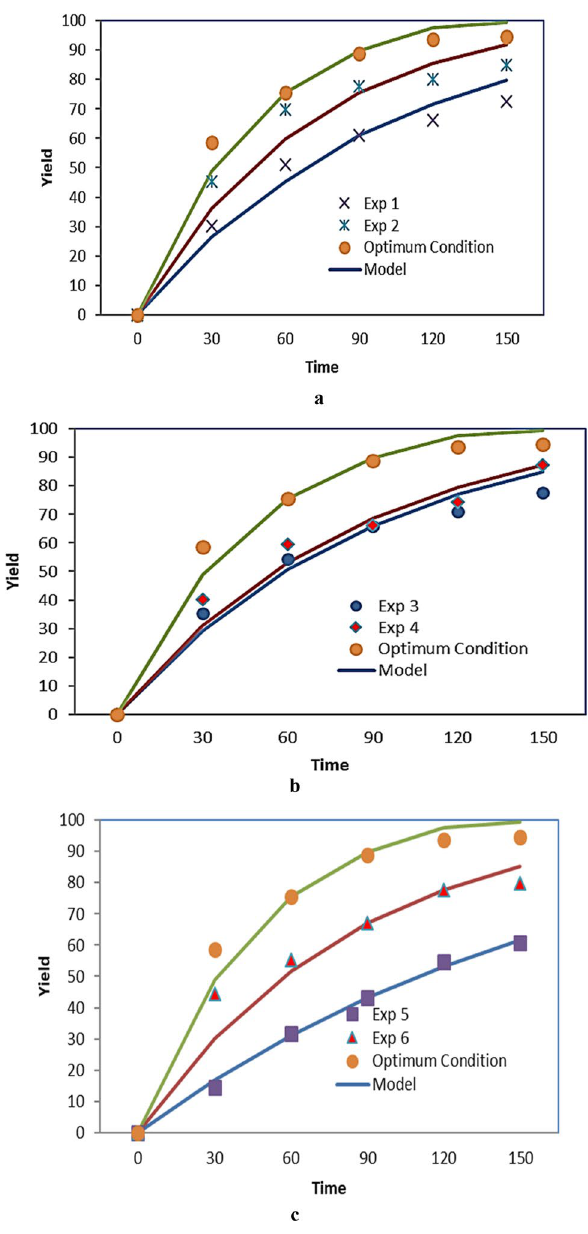
Figure 12. Effect of process parameters on the yield of extraction versus time.